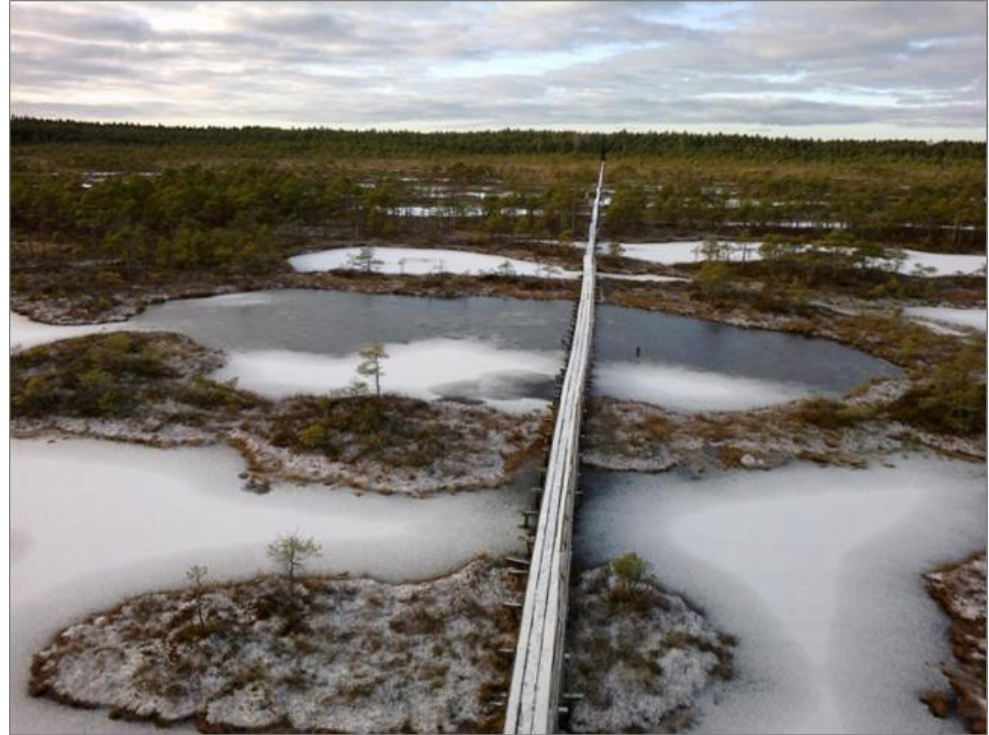
Figure 2. Ridge-pool ecotope (GW well sites Mä213 and Mä211) at Männikjärve Bog, crossed by the wooden trail of the east–west hydrological transect of Tooma Mire Station, November 2013. Photo: L. Küttim.